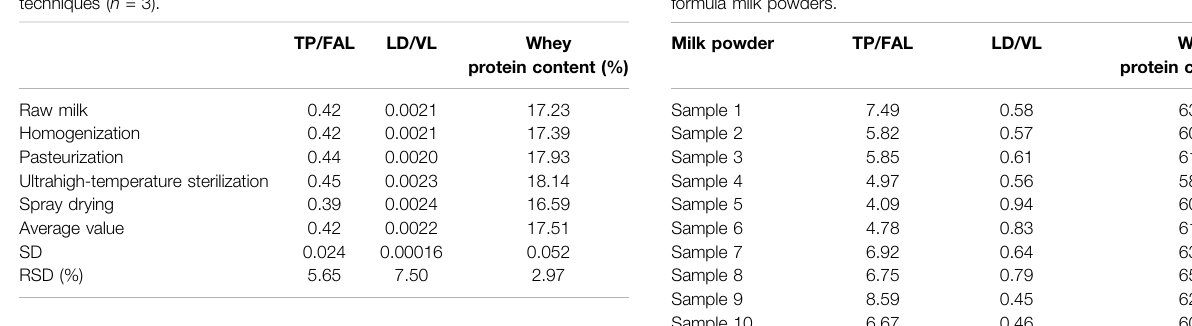
TABLE 6 | Quantitative detection of whey protein with different processing techniques ( n = 3).